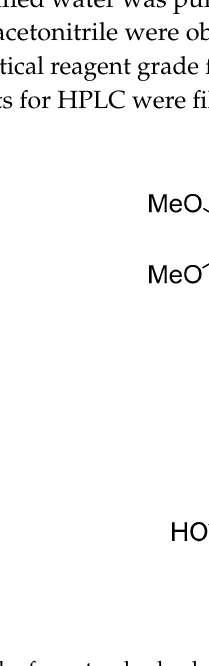
Figure 7. Structures of the four standard substances.